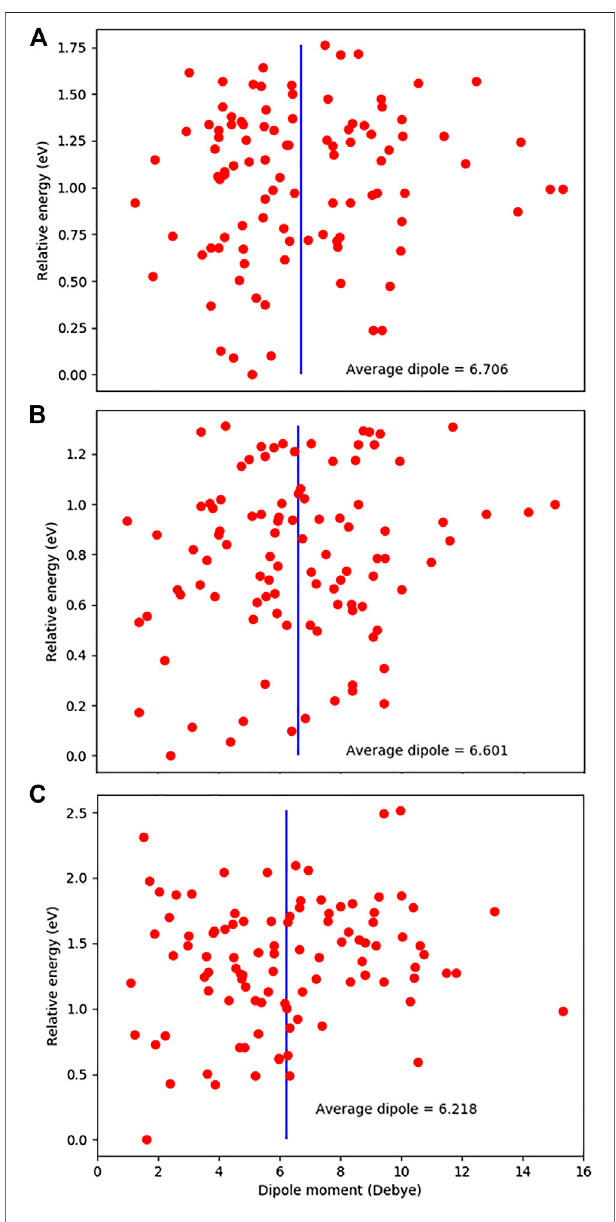
FIGURE 3 | Plot of relative energy vs. dipole moment for hydroxylated (MgSiO 3 ) 6 nanosilicates for (A) one, (B) two, and (C) three water molecules. The vertical blue line denotes the average dipole moment of the set.